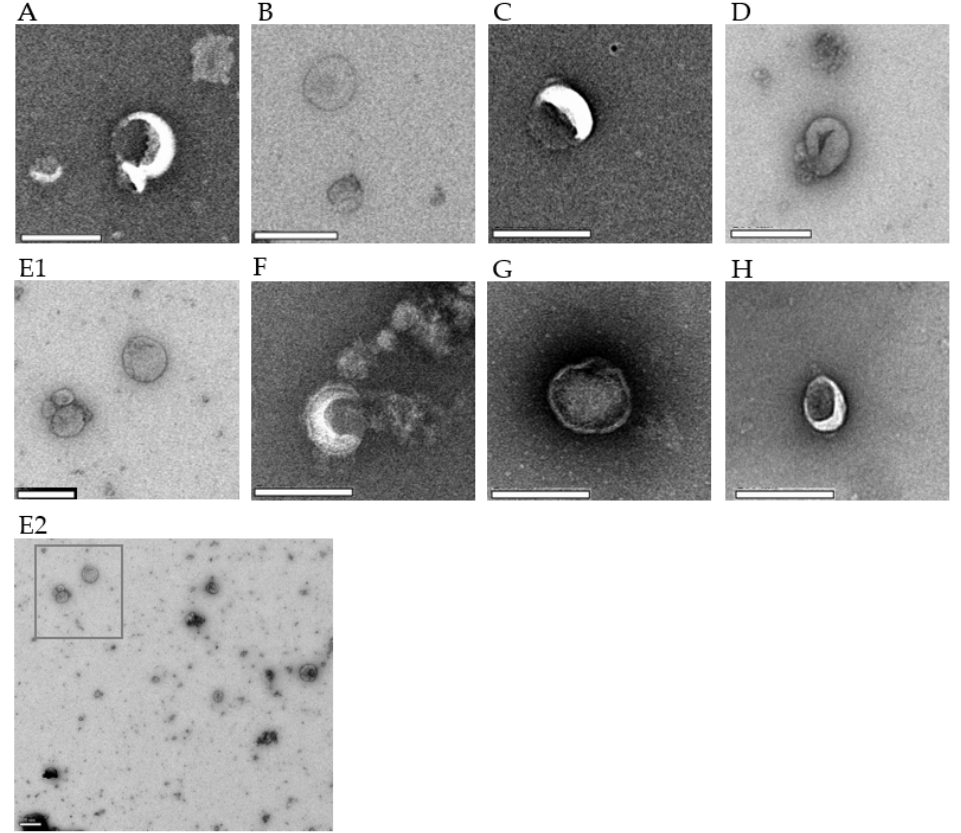
Figure 3. TEM micrographs of P. falciparum iRBC EVs and uRBC EVs. Each image is representative of 4–6 captures. ( A ) Ring-P10, 18,500 × ( B ) Ring-P100, 18,500 × ( C ) Trophozoite-P10, 23,000 × ( D ) Trophozoite-P100, 18,500 × ( E1 ) Schizont-P10, 13,000 × ( E2 ) A representative wide-field image showing heterogeneity of EVs; E1 was taken from this field ( F ) Schizont-P100, 23,000 × ( G ) uRBC-P10, 23,000 × ( H ) uRBC-P100, 23,000 × . Scale bar–200 µ m. The size distribution of EVs was corroborated by NTA, which showed the majority of P10 and P100 EV samples to be between 100 and 300 nm in diameter (Figure 4A,B). As shown in Figure 4A, the peak diameter for P10 EVs slightly varied across the different populations as follows: ring-iRBCs–179.3 nm, trophozoite-iRBCs–121.8 nm, schizont-iRBCs– 154.1 nm and uRBCs–129.6 nm. The peak diameter for P100 EVs (Figure 4B) was as follows: ring-iRBCs–159.7 nm, trophozoite-iRBCs–116.9 nm, schizont-iRBCs–148.6 nm and uRBCs– 134.6 nm. For both P10 and P100 EV isolates, the largest to smallest EVs were rings > schizonts > uRBCs > trophozoites. These modal sizes all correspond to the physical characteristic of small EVs, which are determined to be <200 nm